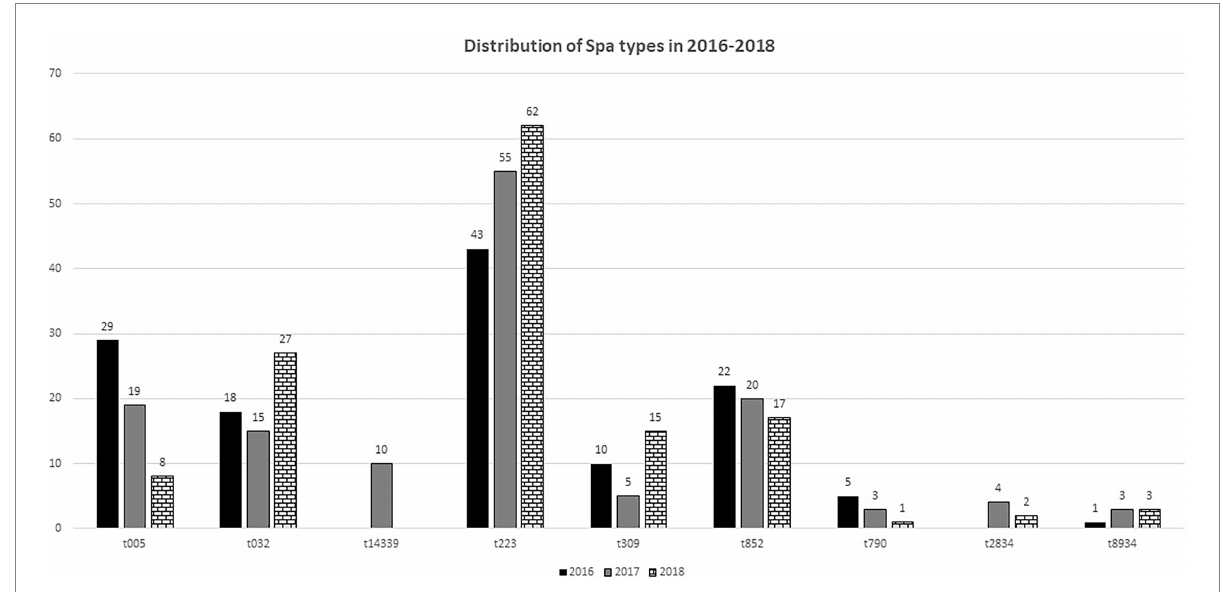
FIGURE 1 Distribution of the common spa types in CC22-MRSA isolates in